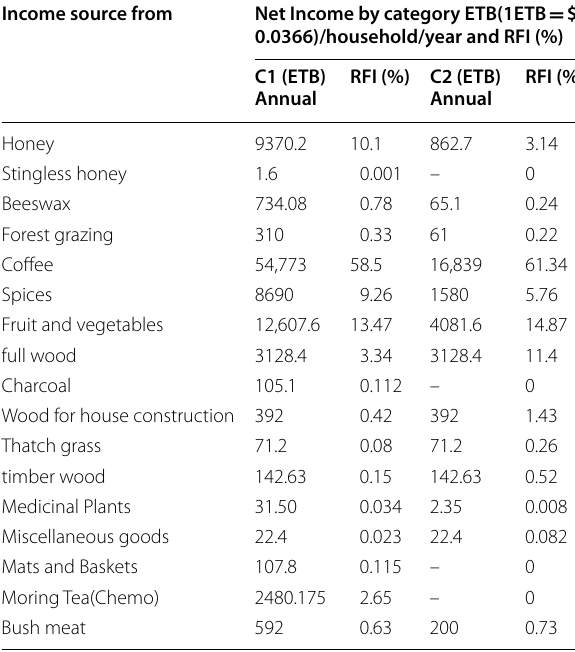
Table 3 Annual average and Relative forest income (RFI) by forest income source on C1 and C2 groups in southwest Ethiopia Coffee